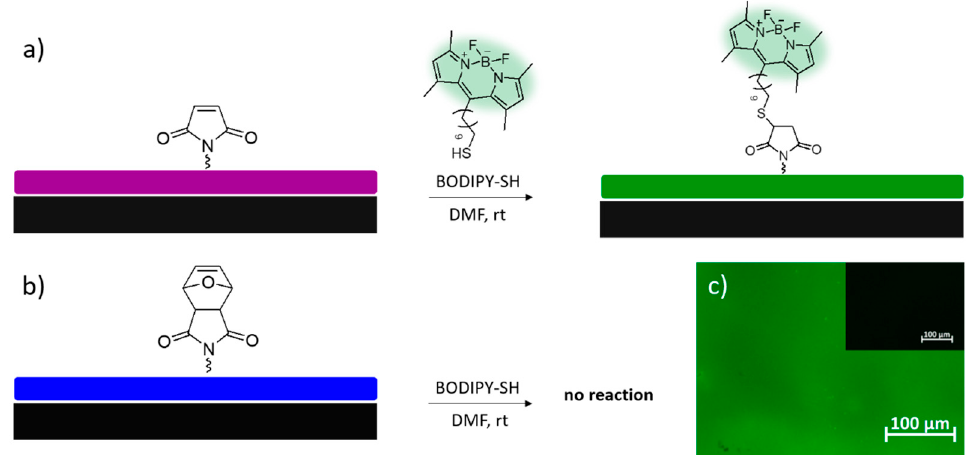
Figure 3. ( a ) Scheme of immobilization of BODIPY-SH onto hydrogel R-H1, ( b ) control experiment with protected maleimide containing surface, and ( c ) and fluorescence microscope images of dye immobilization (inset: control reaction).